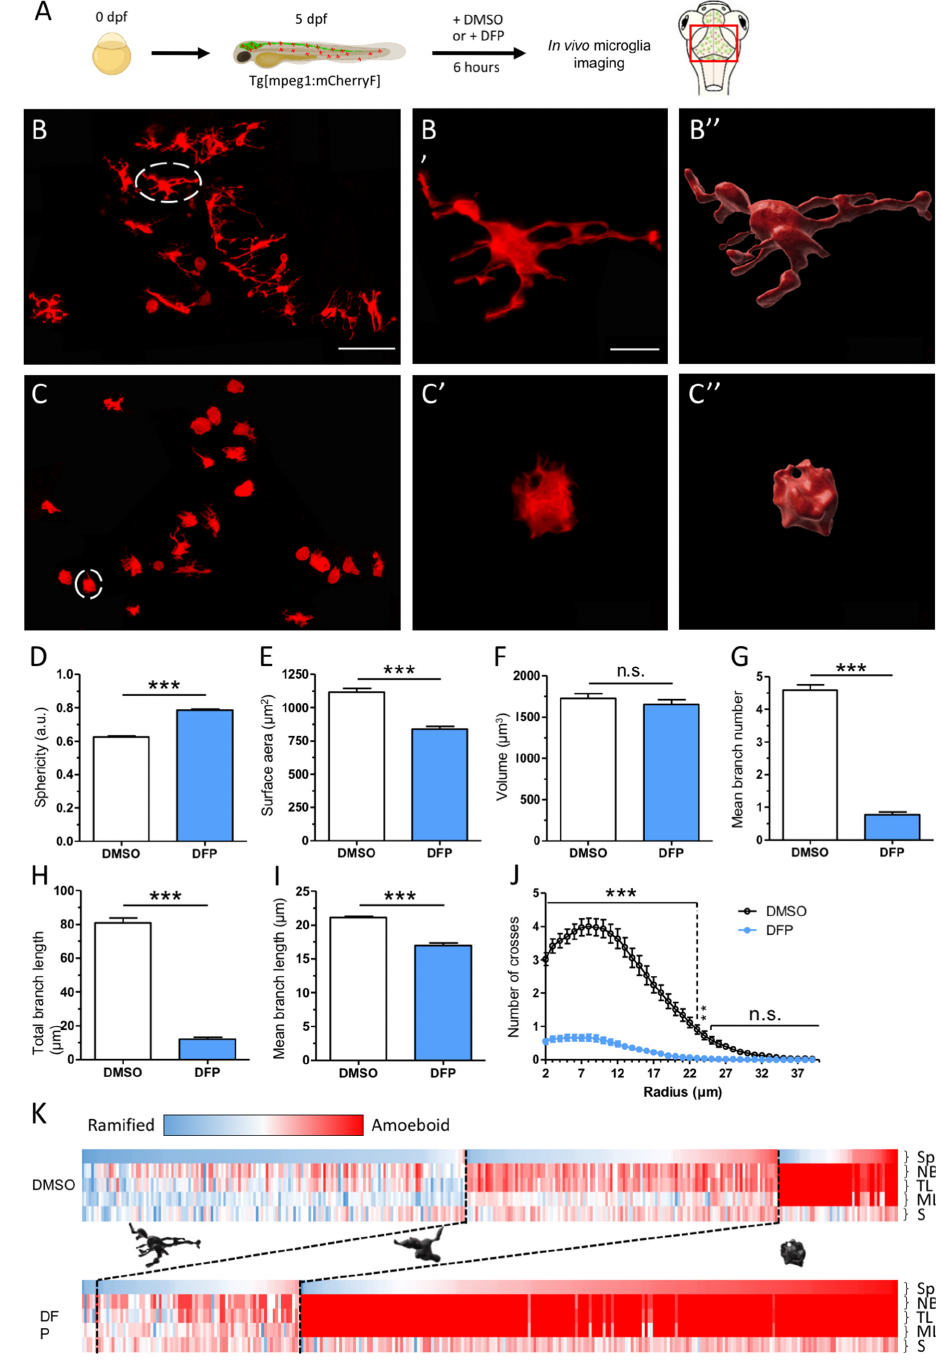
Figure 1. DFP exposure induced major morphological changes of microglial cells. ( A ) Scheme of the experimental set up. Live 5 dpf Tg[mpeg1:mCherryF] larvae were exposed to either 1% DMSO